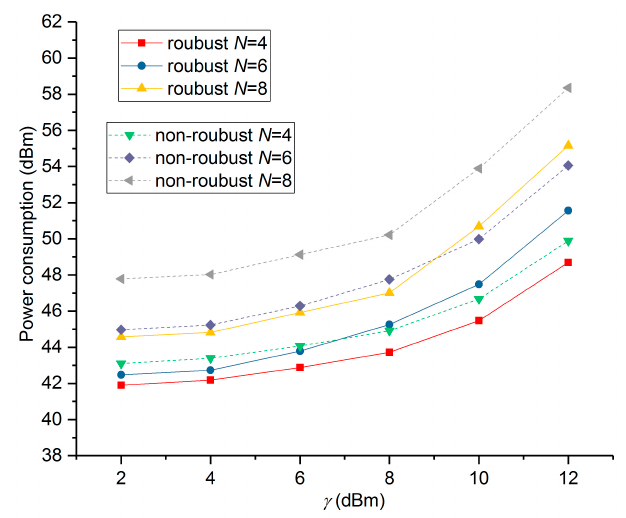
ff erent number of transmit